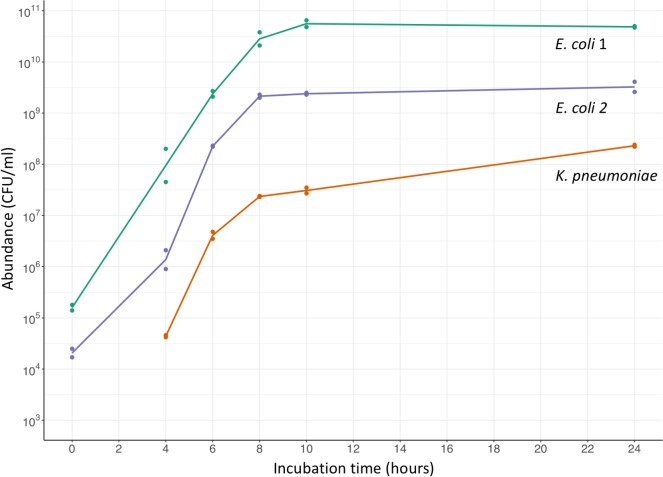
Growth of Enterobacteriaceae during incubation of a fecal sample.A single sample was incubated in broth containing vancomycin and metronidazole. Two distinct morphotypes of E. coli were present. No K. pneumoniae were isolated at 0 hours, implying presence below the limit of detection of 103 CFU/g. Lines join the geometric means of 2 replicates.